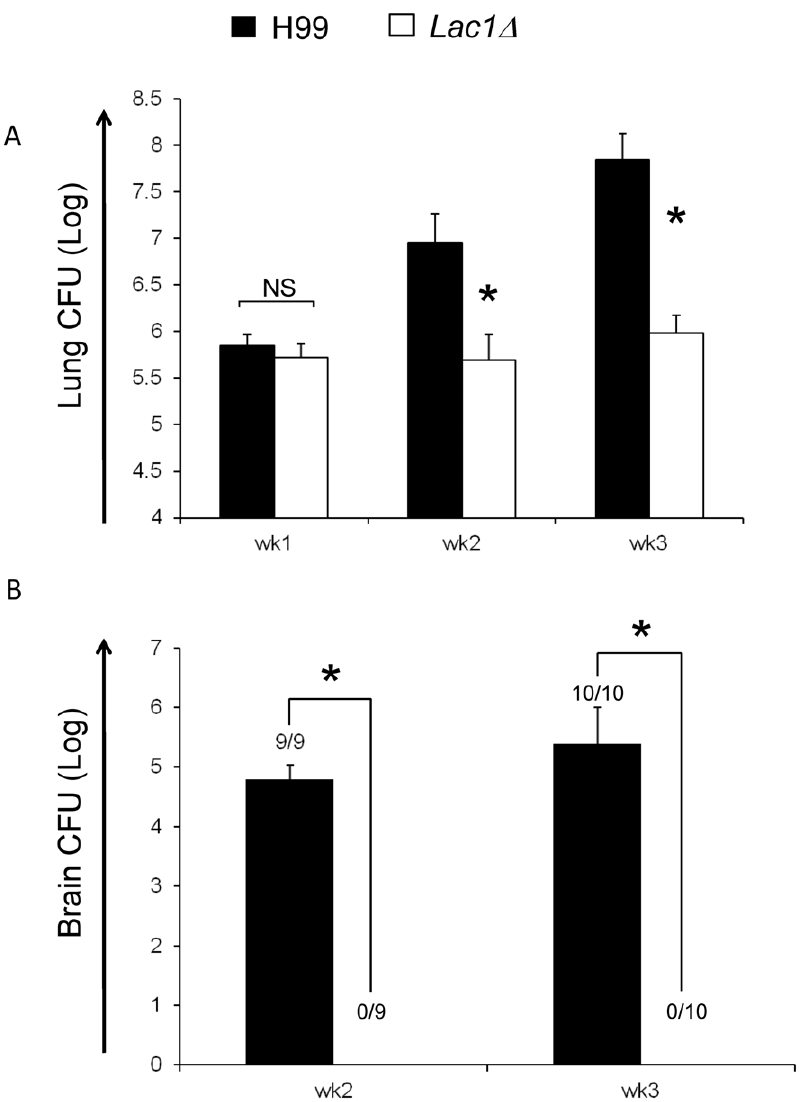
Figure 1. Effect of cryptococcal laccase on fungal clearance. Mice were inoculated intratracheally with 10 4 C. neoformans strain H99 or lac1 D . Lungs were harvested at weeks 1, 2, and 3 post-infection for analysis of fungal burden (A); brains were harvested at weeks 2, and 3 post-infection for analysis of fungal burden (B). Note the dramatically decreased fungal burden in the lungs and brains of lac1 D infected mice compared with H99 infected mice. Data, mean CFU 6 SEM log 10 , were pooled from 2–3 separate matched experiments, N =6 and above for each of the analyzed parameters; *p , 0.05 in comparison between wt and mutant; NS, no significant difference between wt and mutant.